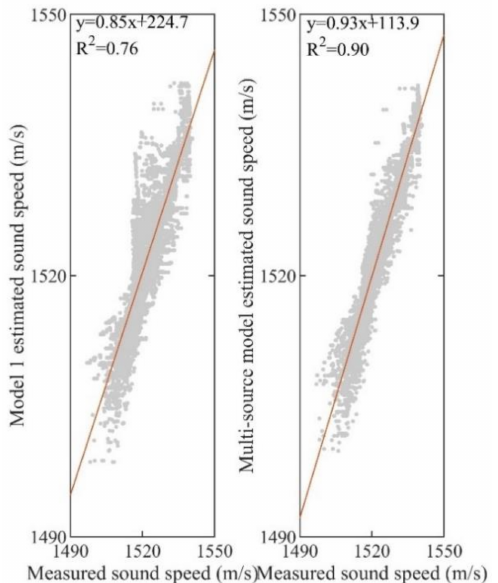
Figure 5. Scatter in the measured and estimated speeds of sound obtained by different